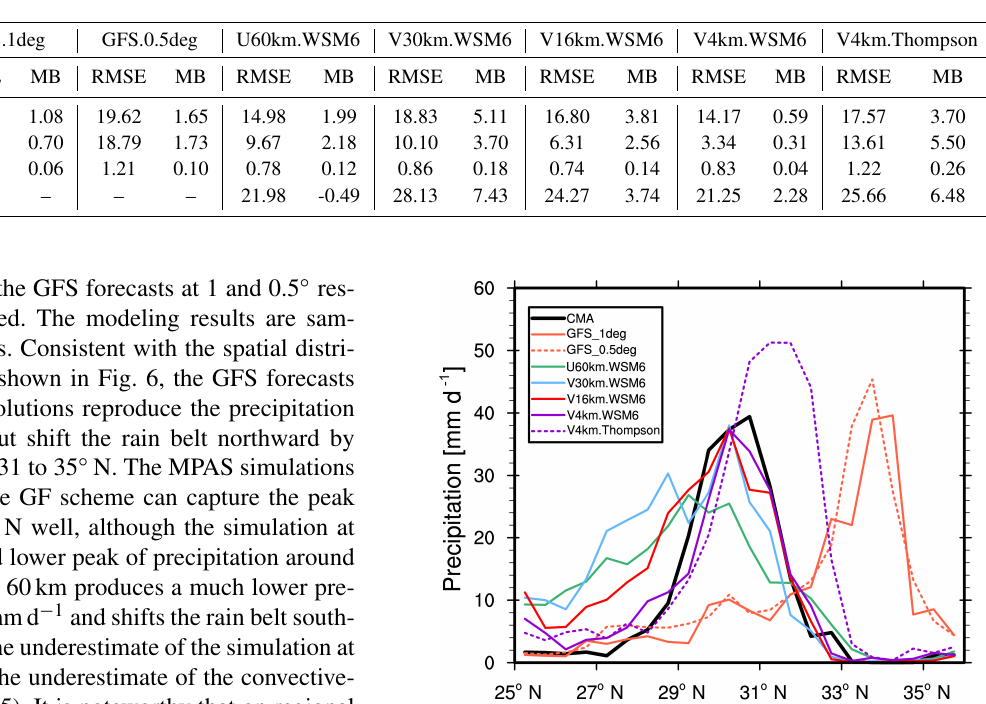
Table 2. The mean bias (MB) and root mean square root (RMSE) of the simulated results shown in Figs. 6–8 and 10 against CMA observa- tions.